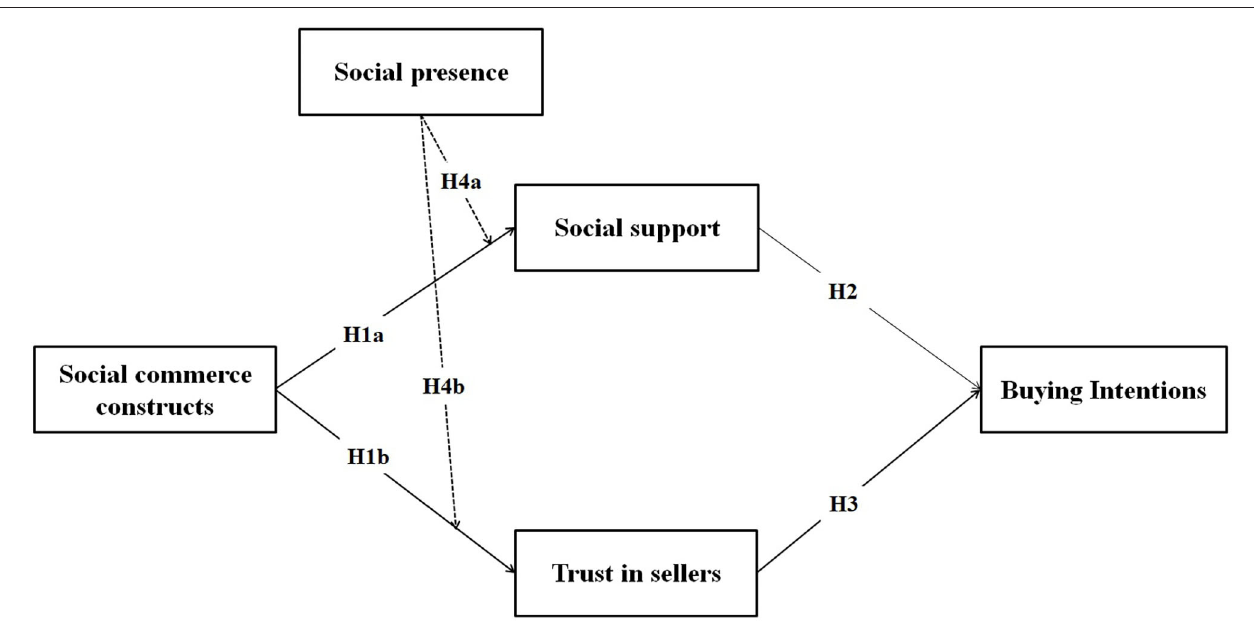
FIGURE 1 | Proposed study